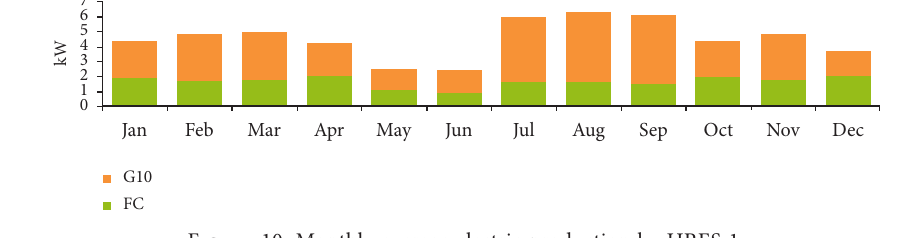
Figure 10: Monthly average electric production by HRES 1.